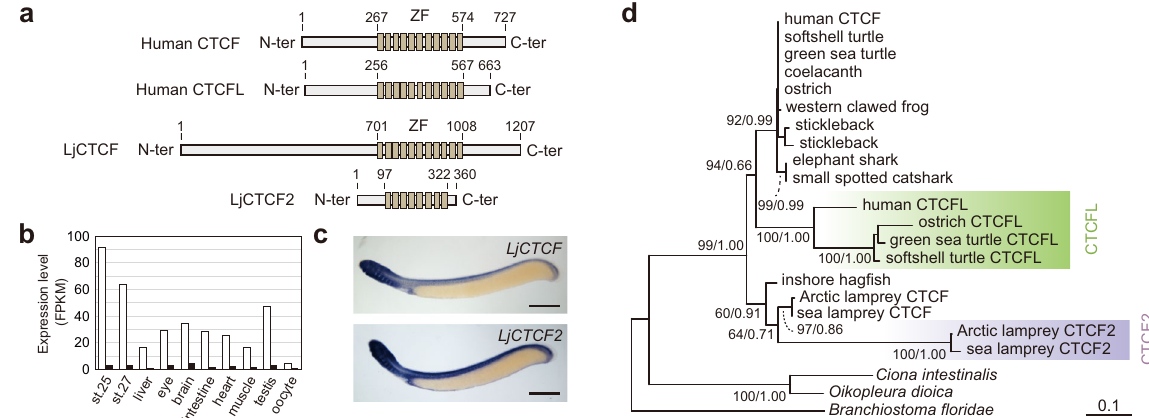
Figure 1. Properties of L. camtschaticum CTCF and CTCF2 genes. ( a ) Protein domain structures, in comparison with human CTCF and CTCFL. The Zn finger domains (ZF) were identified by MOTIF Search (http://www.genome.jp/tools/motif/). See SI Materials and Methods for detail procedures of LjCTCF and LjCTCF2 sequence determination by cDNA cloning. ( b ) Expression levels of LjCTCF (white) and LjCTCF2 (black) in embryos and adult tissues. FPKM, fragments per kilobase of exon per million mapped sequence reads. ( c ) Whole-mount in situ hybridization on stage 26.5 embryos. Riboprobes were designed in non- conserved regions downstream to the Zn finger domains to avoid cross-hybridization (for the magnified view and the result with upstream riboprobes, see Supplementary Fig. S10). Note that the difference in the intensities of the expression signals between the two genes do not correspond to that of actual expression levels, as indicated by our RNA-seq data in ( b ). Scale bars: 500 μ m. ( d ) Molecular phylogenetic tree. This tree was inferred with the maximum-likelihood approach using 208 aligned amino acid sites (see Supplementary Tables S8 and S9 for the list of sequences used). Two stickleback sequences are included (upper, Ensembl ENSGACP00000003270; lower, ENSGACP00000020939). At each branch node in the tree, only bootstrap value of no less than 60, and the posterior probability inferred with the Bayesian approaches are